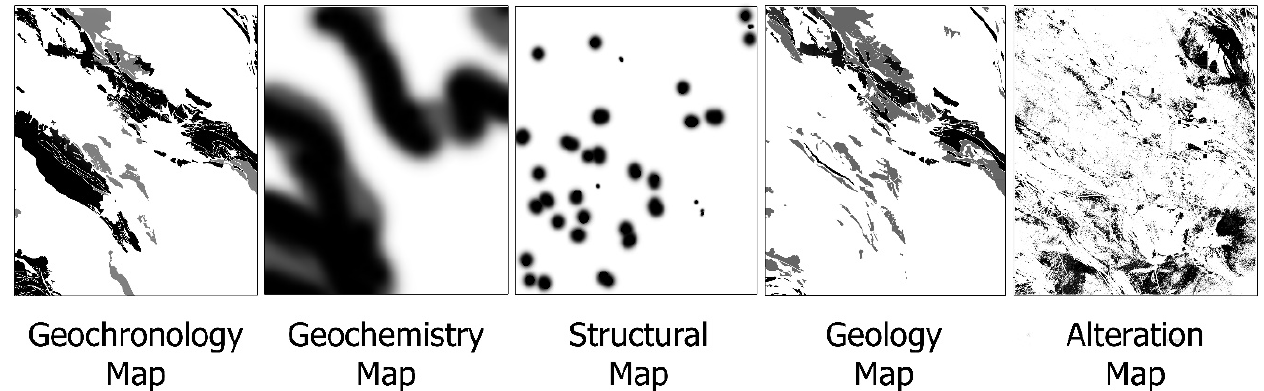
Figure 12. The fuzzified exploratory maps for the Sahlabad mining area.